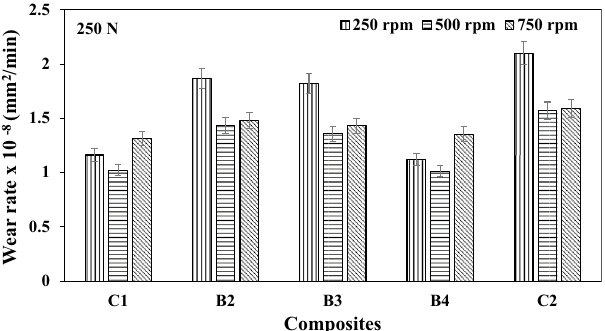
Figure 4. Wear rate of composites at load 250 N under different